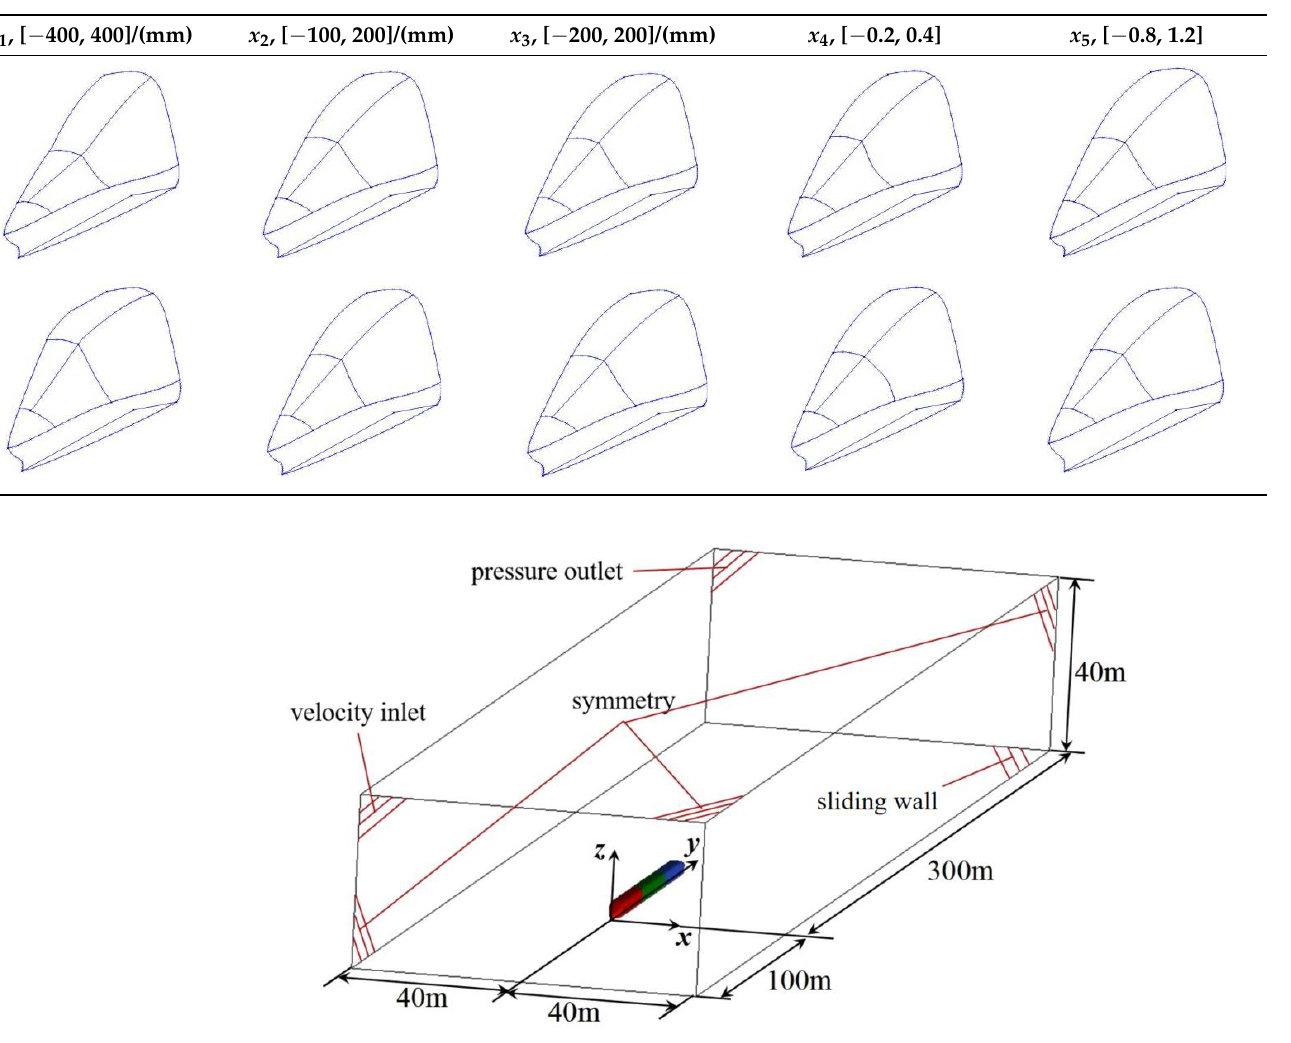
Table 1. Range of design variables and corresponding deformation.